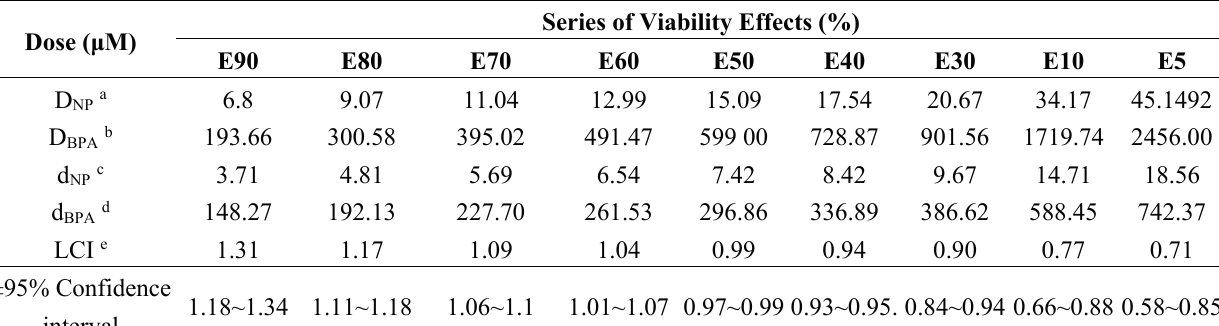
Table 3. Effect of single and combined nonylphenol (NP) and bisphenol A (BPA) on viability of RWPE-1 cells and the LCI derived from the Loewe additivity (LA) model. Dose ( μ M)